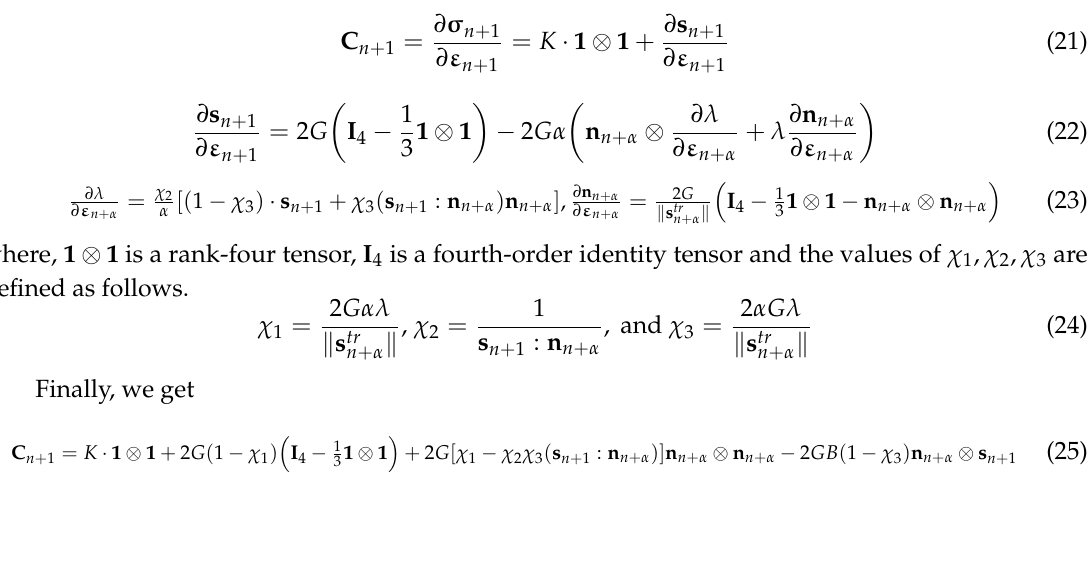
Figure 10. Solution algorithm for quadratic generalized trapezoidal method in J 2 plasticity (by rearranged and casted by the author from Simo et al. [4,5]).